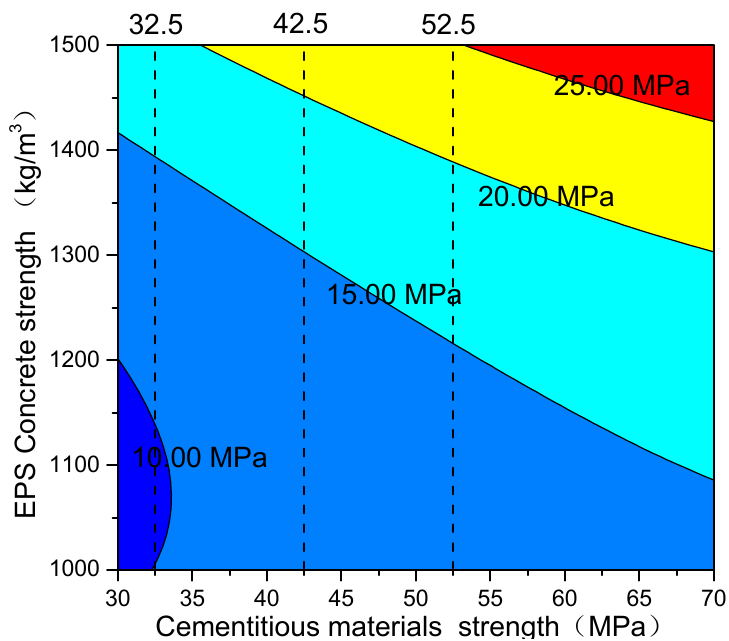
Figure 7. Contour map of the surface fitting map projected on the X-Y plane.